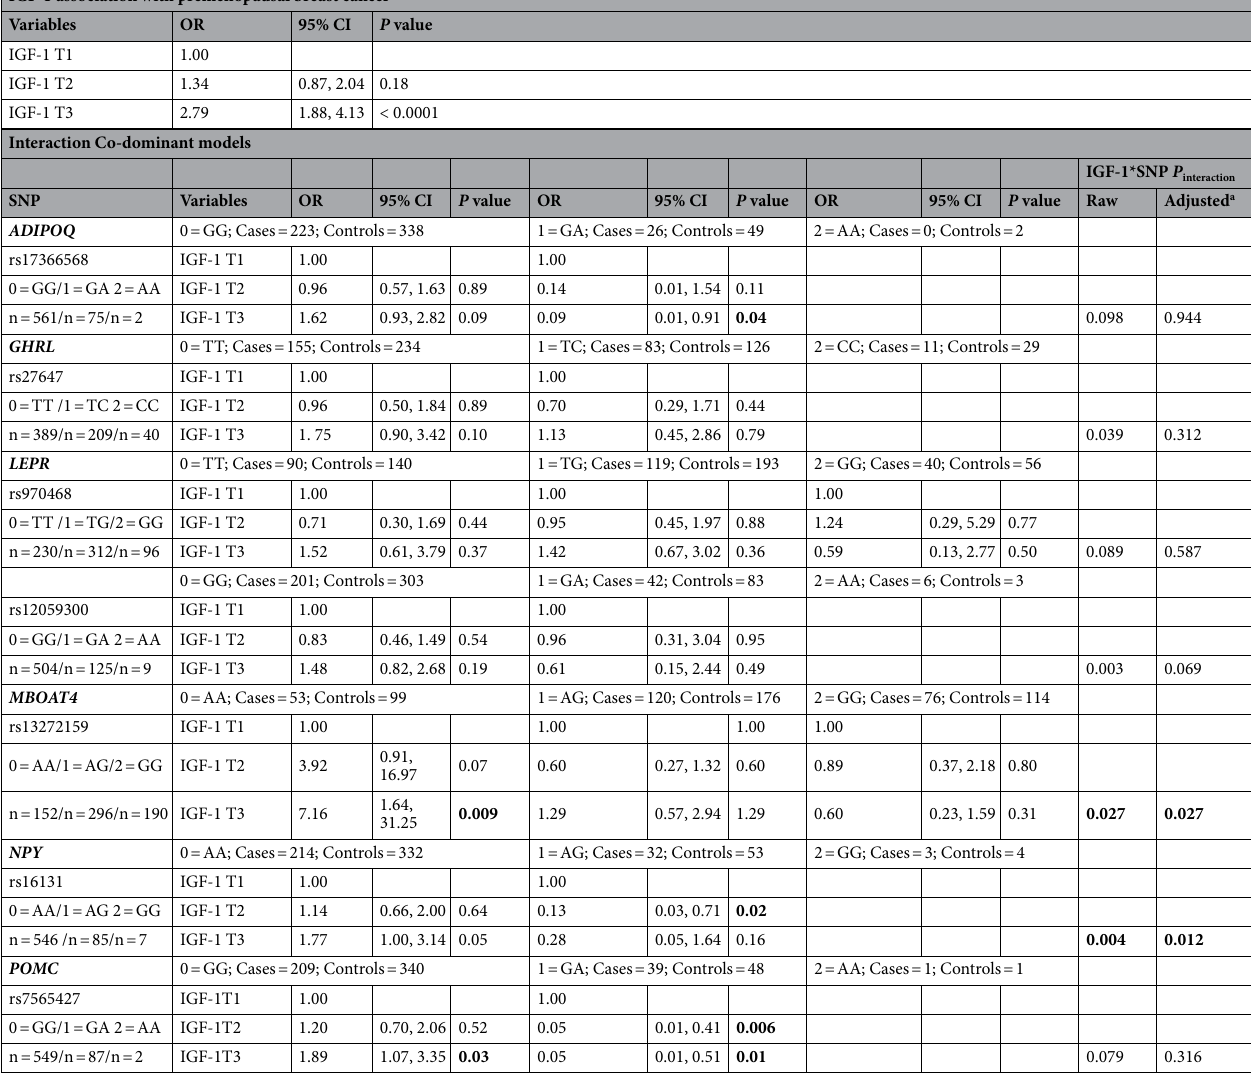
Table 2. Association between serum concentration of IGF-1 and breast cancer by SNPs of genes regulating energy homeostasis, the Breast Cancer Health Disparities Study. The model at the top of the table was not adjusted for potential confounders. The rest of the models were adjusted for IGFBP-3 serum concentration (ng/mL), age (years), genetic ancestry (% Indigenous), BMI (Kg/m2), energy intake (Kcal/day), height (cm), age at menarche (years), ever use oral contraceptives (no,yes), parity (nulliparous, 1 or 2, 3 or more), study (4-CBCS, MBCS), first-degree family history of breast cancer (no, yes), ever alcohol consumption (no, yes) and ever cigarette smoking (no, yes). a Benjamini-Hochberg adjusted P values (correction for the number of SNPs tested per gene); a threshold of 0.2 was considered